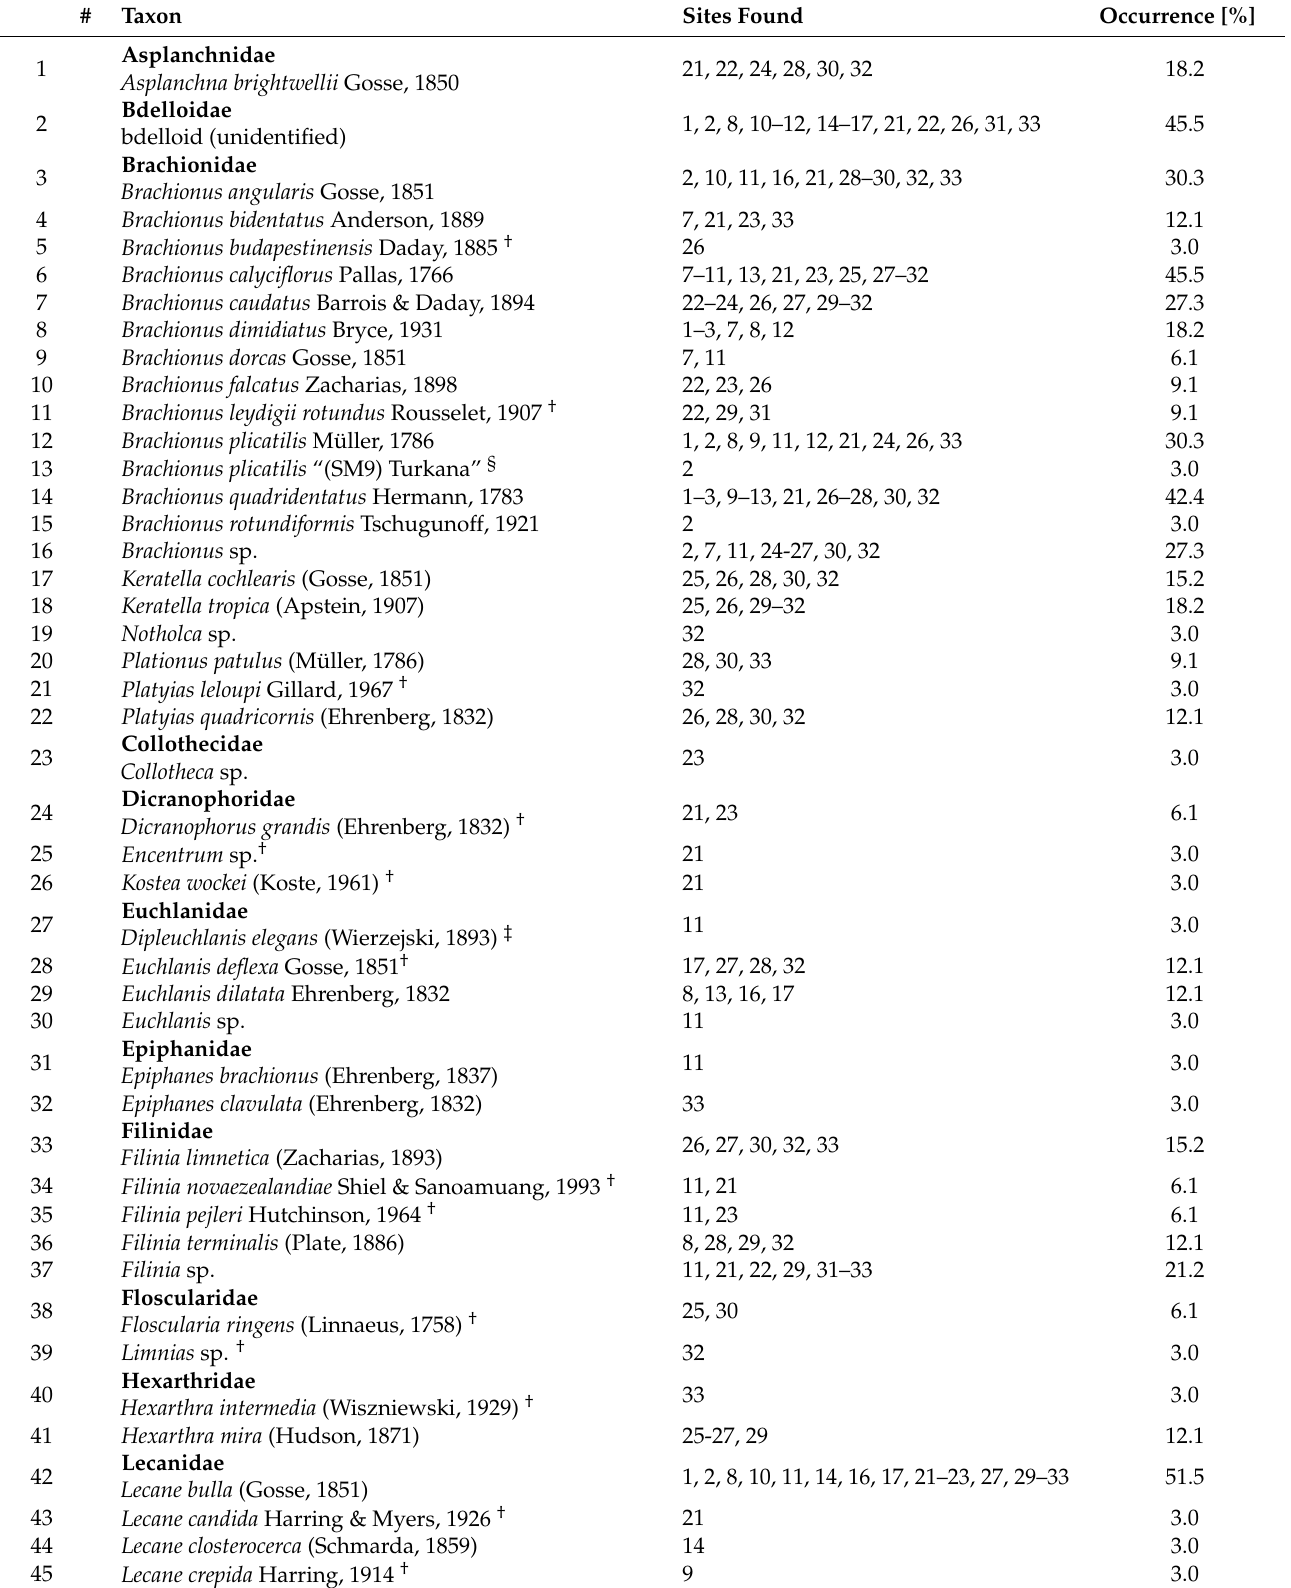
Table 2. Rotifer taxa found in aquatic habitats surveyed in Kenya